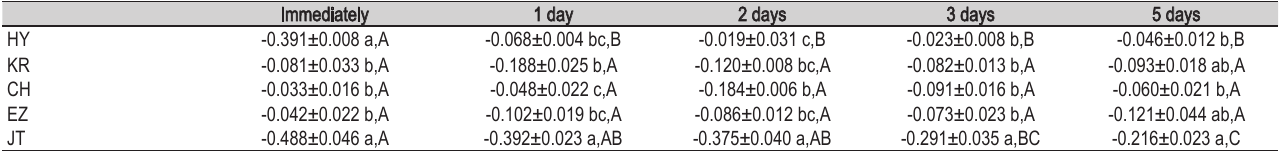
Table 4 - Mean of dimensional alteration and SD (%) of stone casts obtained with different alginates and poured in different periods of time (distance